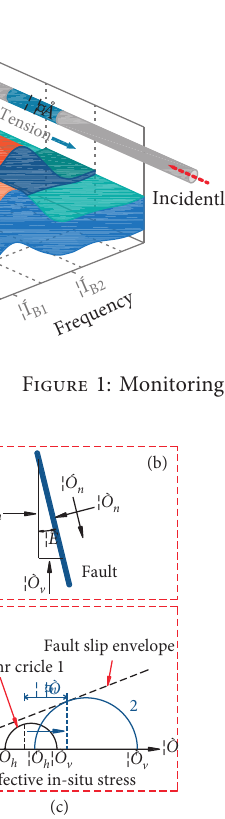
Figure 2: Schematic diagram of the forces and fault stresses in the rock mass adjacent to a staggered positive